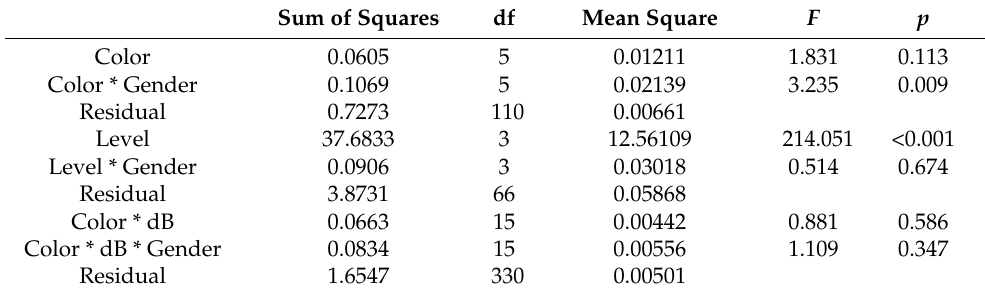
Table 3. ANOVA table (Within Subjects